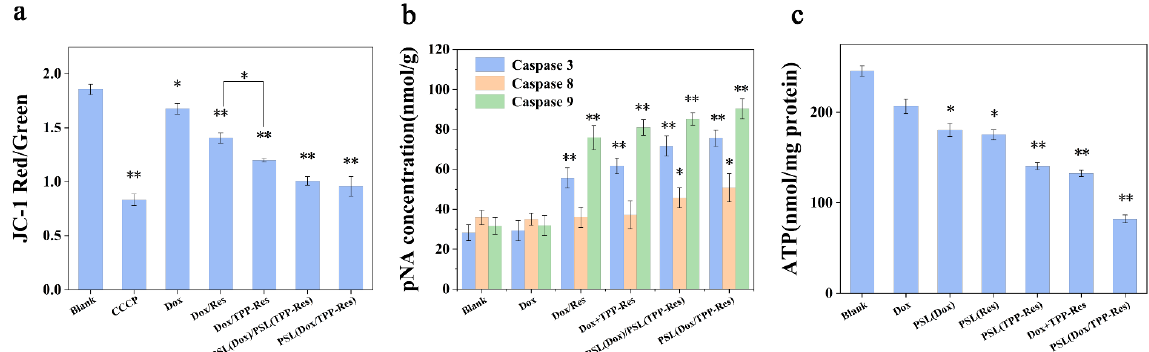
Figure 7. ( a ) The effect on the mitochondrial membrane potential in the CSLCs incubated with different formulations. ( b ) Activity of caspase-3, caspase-8 and caspase-9 in the CSLCs incubated with different formulations. ( c ) Intracellular ATP in the CSLCs incubated with different formulations. Data were expressed as mean ± SD (n = 3), * p < 0.05, ** p < 0.01 compared with the blank group.